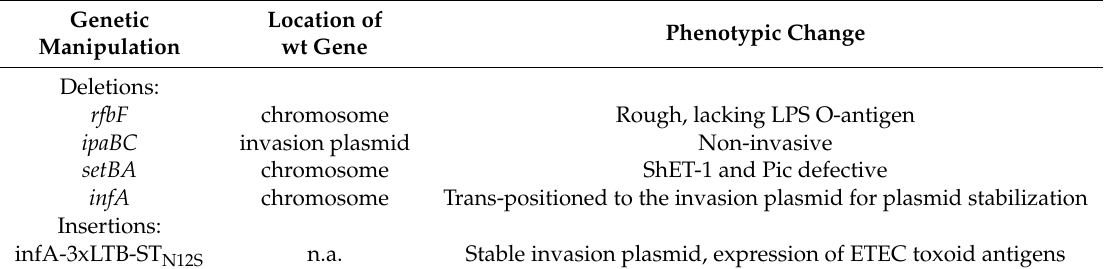
Table 1. Overview of the genetic manipulations introduced to the Shigella flexneri 2a 2547T strain to generate the ShigETEC